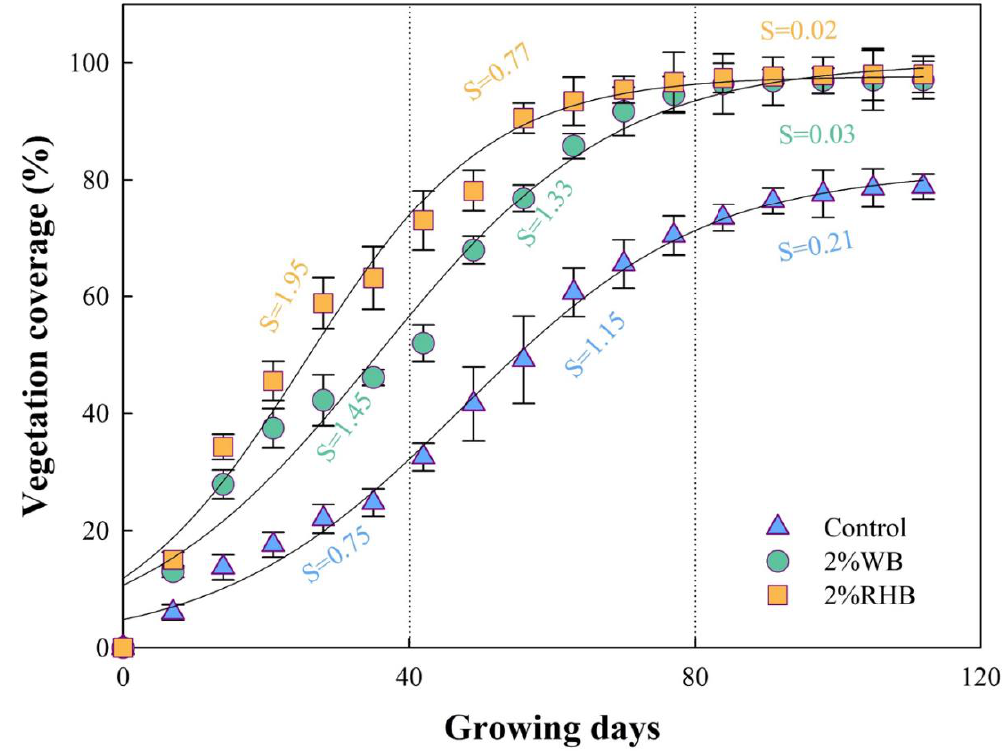
Figure 6. VC estimation during growing period (July to October 2018). “S” indicates slope gradi- ent.